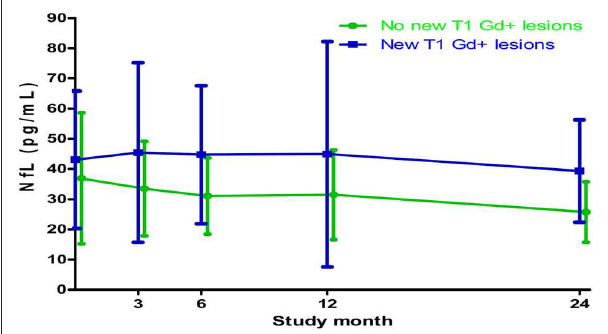
FIGURE 4 | Mean (SD) serum NfL levels in patients with and without new T1-weighted gadolinium-enhancing (T1 Gd + ) lesions on MRI scans throughout the study. Based on all available NfL measurements from a minimum of 79 patients at each point of time.